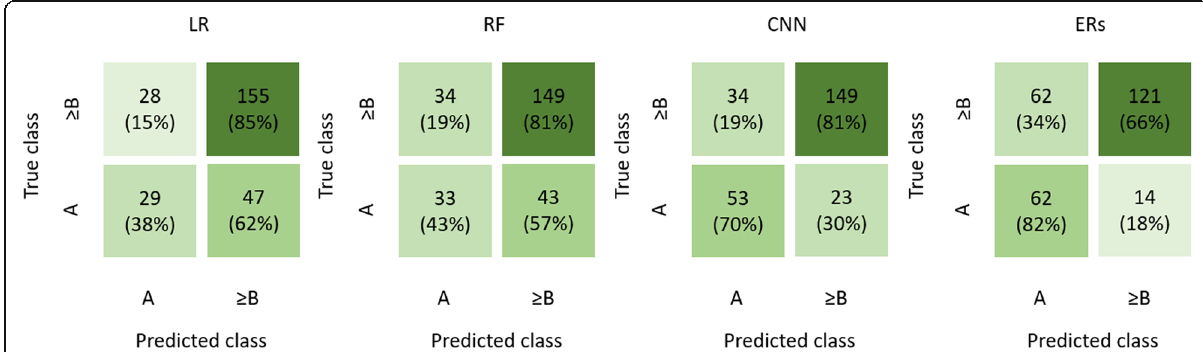
Fig. 4 Confusion matrix for the prediction of low disease severity (Child-Pugh class A) and advanced disease severity (Child-Pugh class ≥ B). Linear regression (LR), random forest (RF), convolution neural network (CNN), and experienced radiologists (ERs). Values in brackets are relative to the numbers of patient in the ground truth Child-Pugh class.